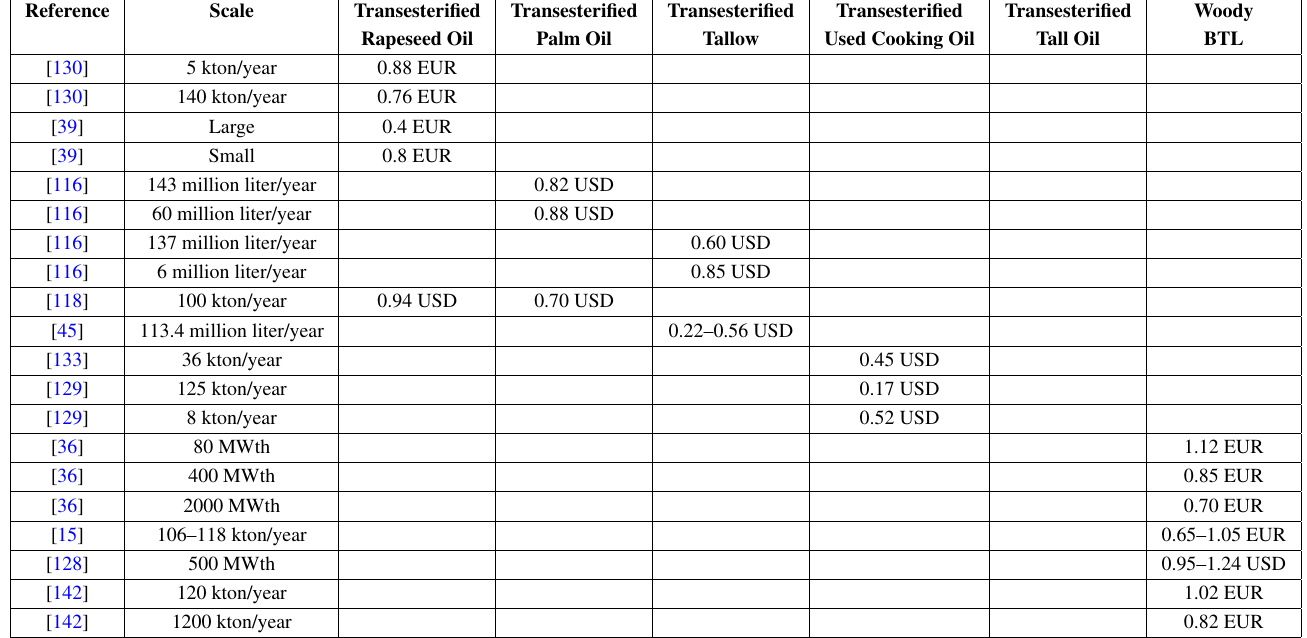
Table 5. Review of fuel production costs per